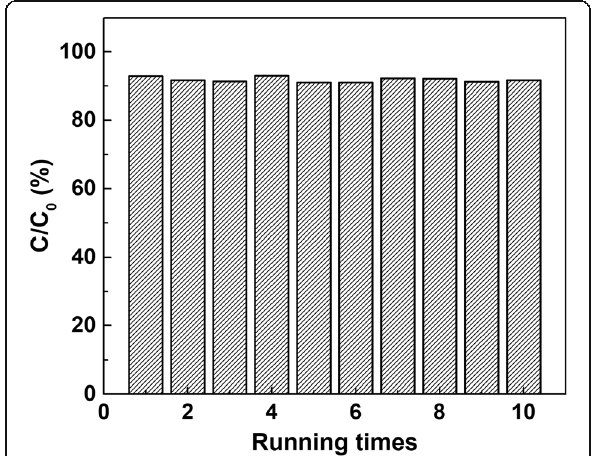
Fig. 6 Reusability test of EC-PANI/TiO 2 NTAs under optimal